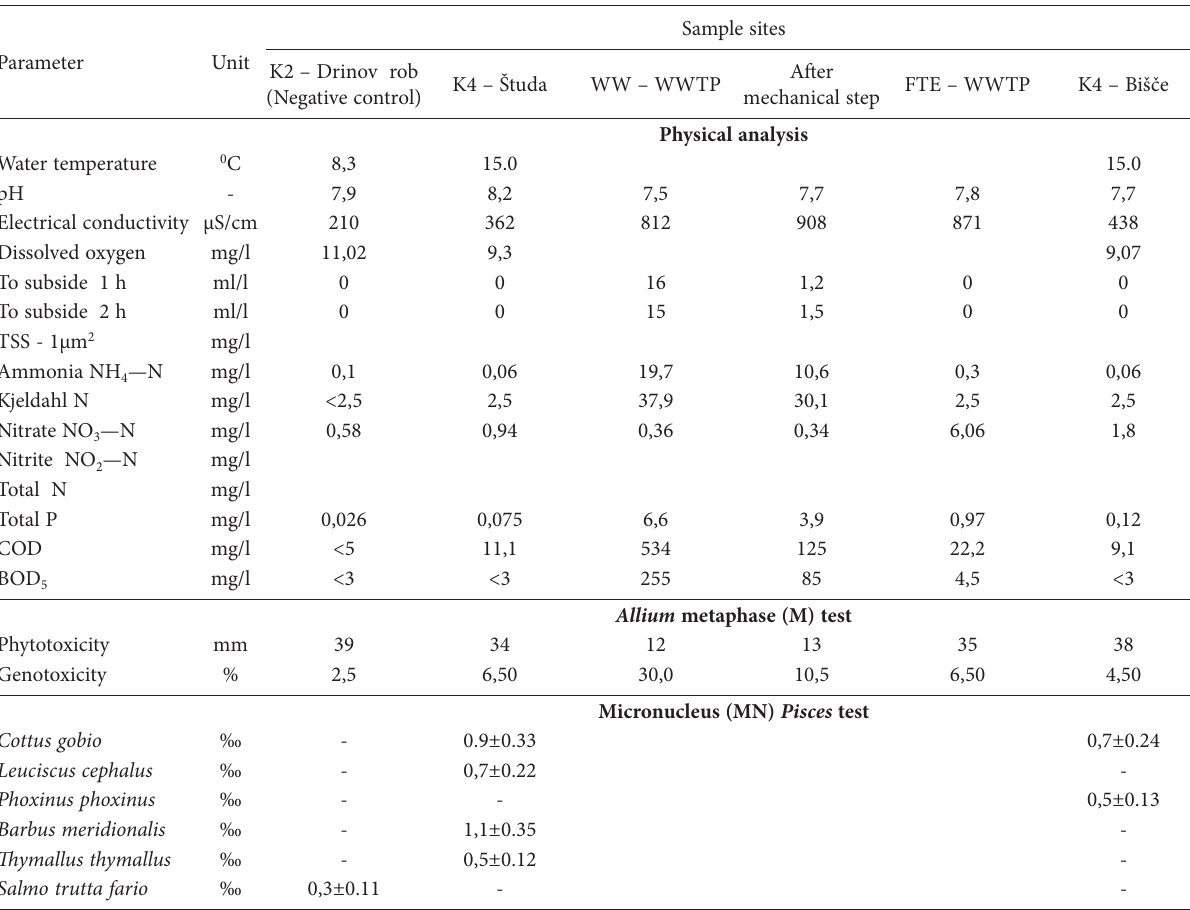
Table 6. United parameters physical quantities; cytological effects of the investigated samples survey – the genotoxicity level (damage to chromosomes) and general toxicity - phytotoxicity (root length inhibition) on the test onion plant A. cepa and Pisces micronuclei